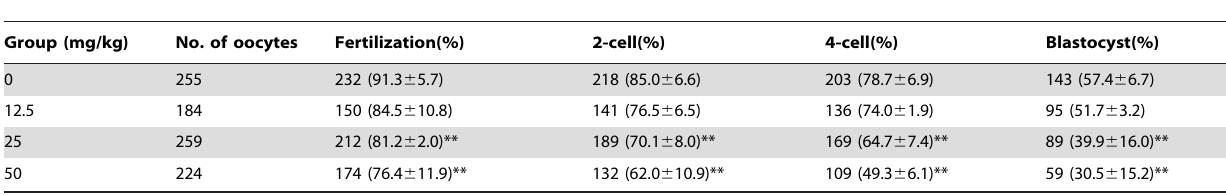
Table 2. Effects of Aroclor 1254 treatment on mouse fertilization and preimplantation embryonic development.